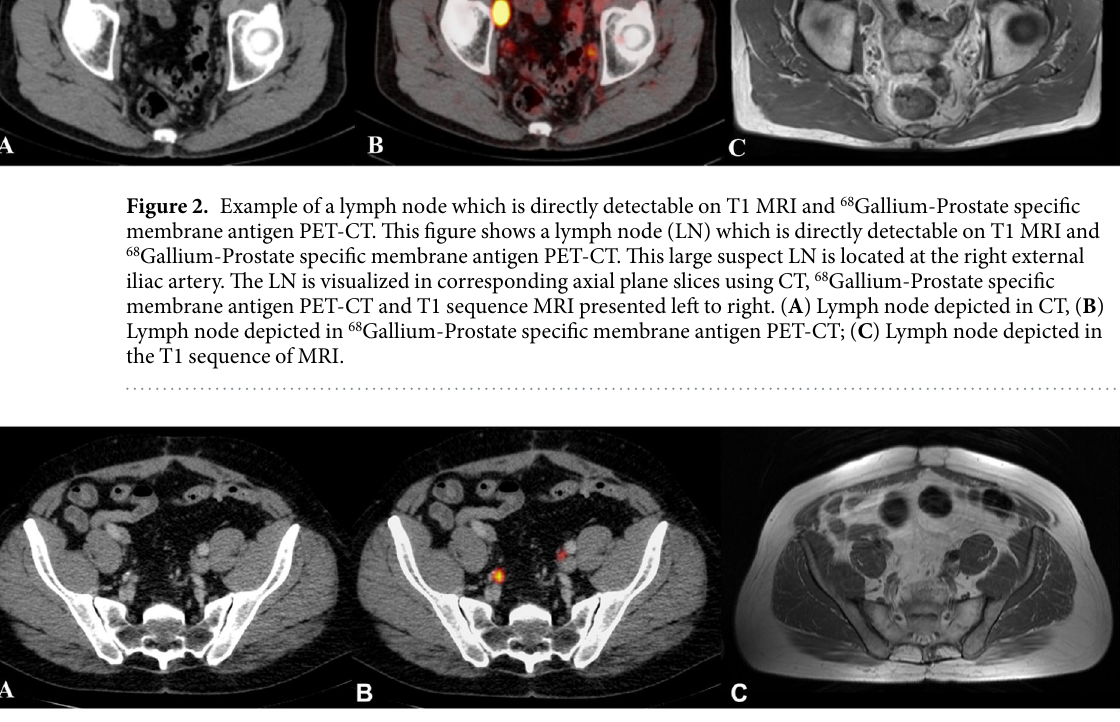
Figure 3. Example of a lymph node which is challenging to detect on T1 MRI compared to the 68 Gallium- Prostate specific membrane antigen PET-CT. This figure presents an example of a lymph node close to the iliac bifurcation. The right and left external and internal iliac bifurcations are visualized in corresponding axial plane slices using CT, 68 Gallium-Prostate specific membrane antigen PET-CT and T1 sequence MRI presented left to right. ( A ) Lymph node depicted in CT, ( B ) Lymph node depicted in 68 Gallium-Prostate specific membrane antigen PET-CT; ( C ) Lymph node depicted in the T1 sequence of MRI.